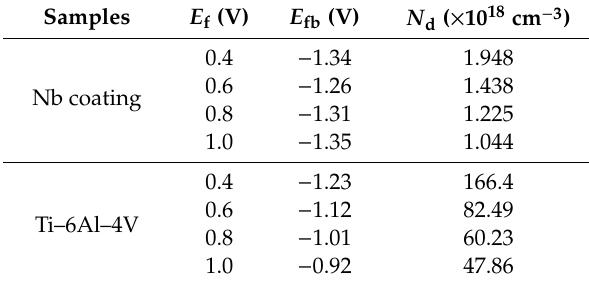
Table 3. Electrochemical parameters collected from capacitance measurement of the niobium coating and the substrate.